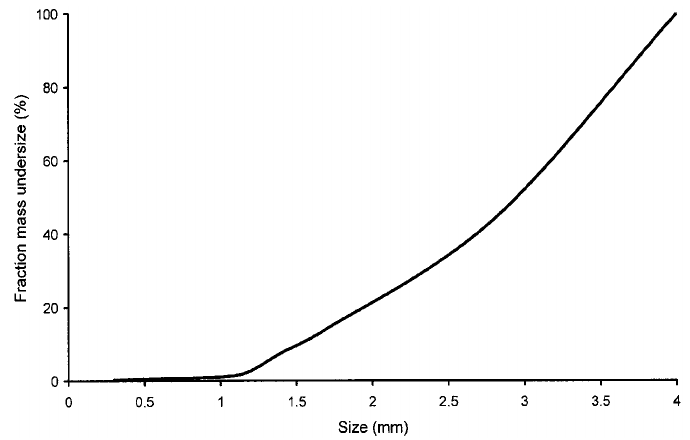
Figure 1. Particle-size distribution after